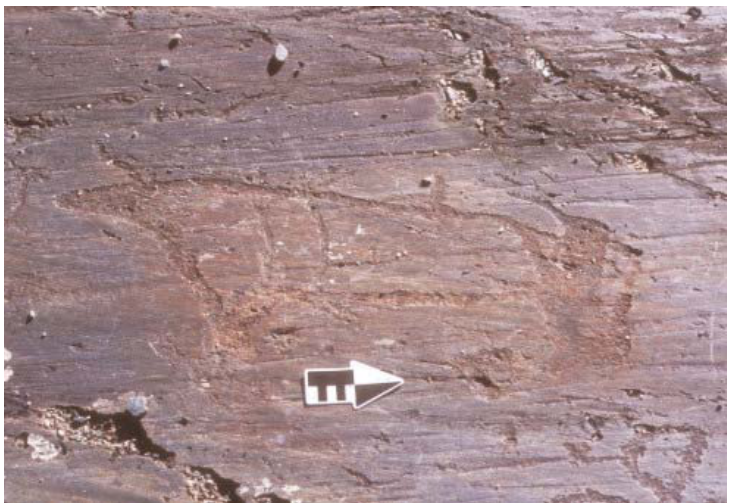
Figure 23. Aurochs superimposed on a small, contoured animal and overlaid by a silhouetted argali. Pre-Bronze Age. Aral Tolgoi. (http://boundless.uoregon.edu/u?/